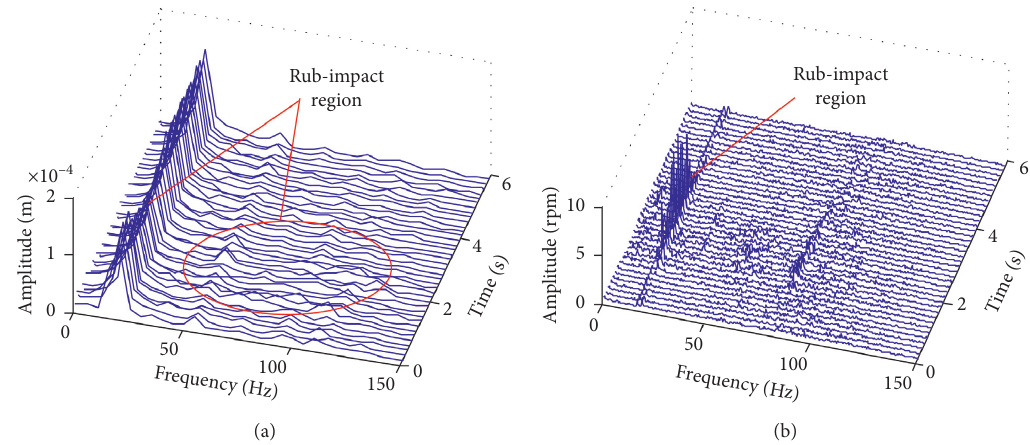
Figure 21: Transient time-frequency waterfall curves of the bending and torsional motions of the rotor test rig during the flight of the base motion platform ( t ∈ [ 0s , 6 s ]) . (a) Bending motion and (b) torsional motion.